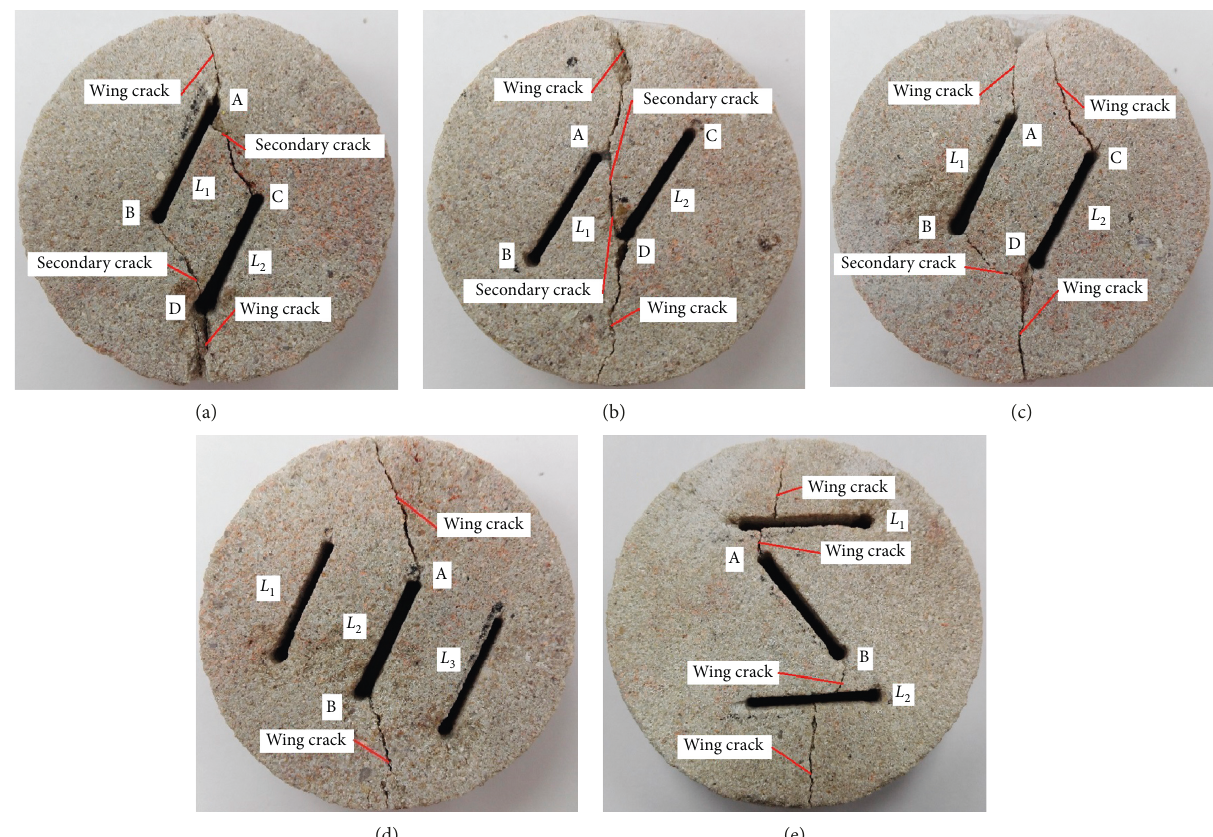
Figure 9: Experimental results of crack propagation and coalescence in specimens with different types of pre-existing crack systems. (a) Forward echelon crack system. (b) Inverse echelon crack system. (c) Two parallel cracks. (d) Three parallel cracks. (e) Crack system with barrier cracks.